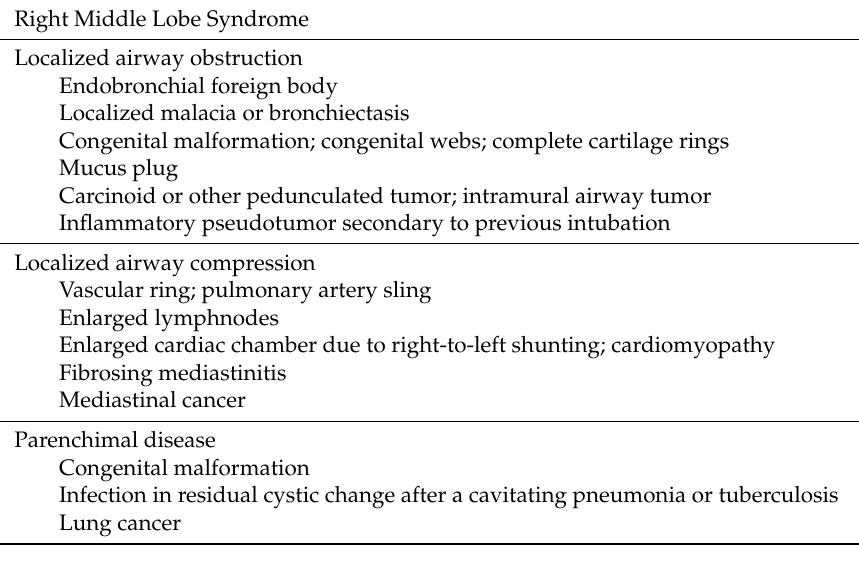
Table 3. Underlying causes of recurrent or chronic pneumonia in the same lobe or